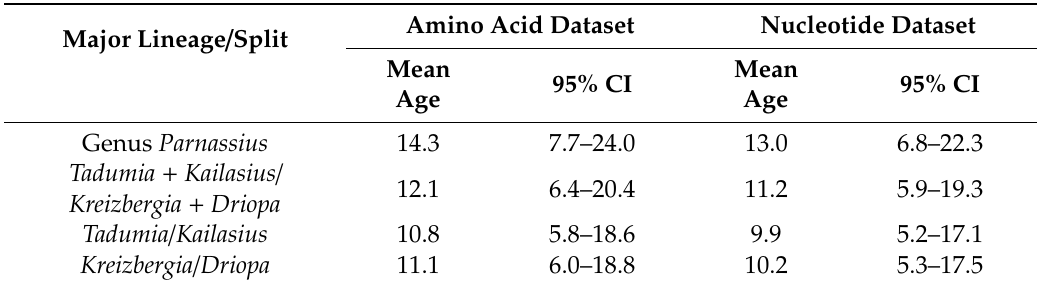
Table 1. Comparison of crown ages with the 95% confidence interval (CI) of major lineages and the most recent common ancestor (MRCA) of major splits in genus Parnassius across di ff erent